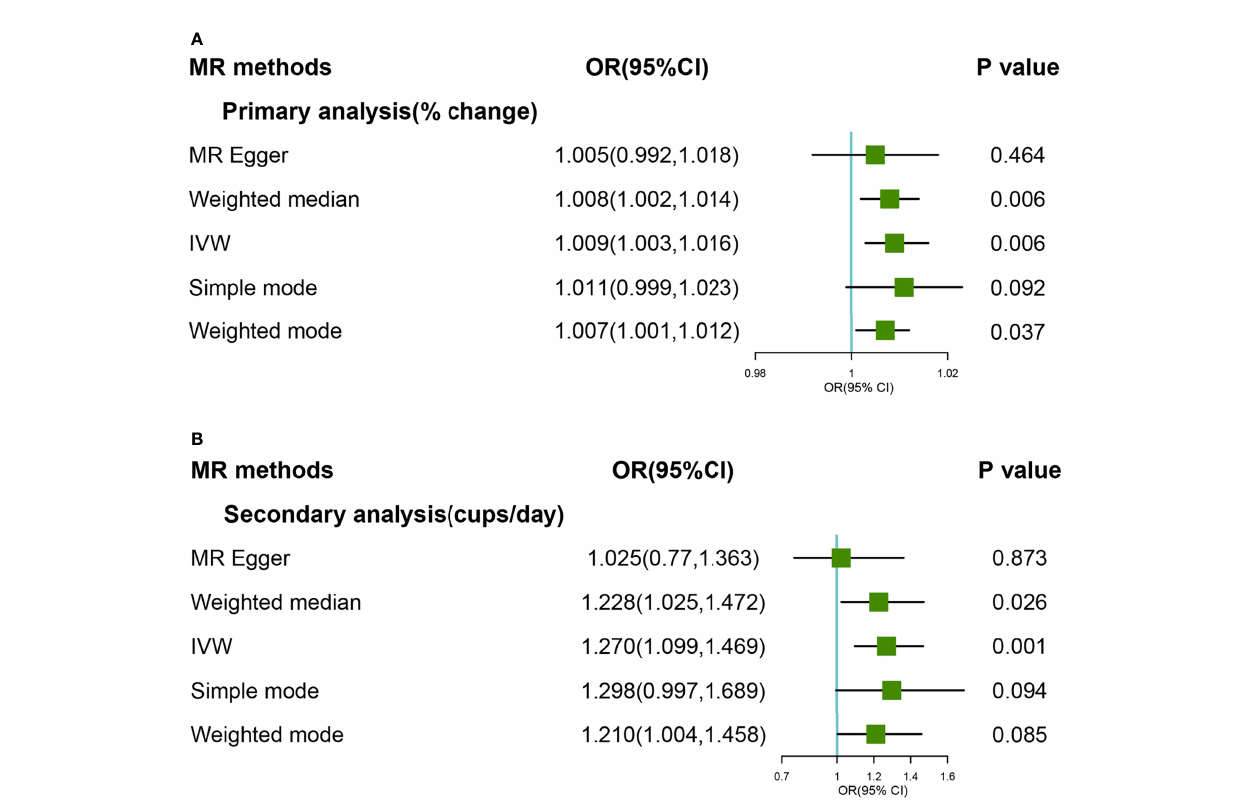
FIGURE 1 | Forest plot of MR study using (A)> primary genetic instruments with total OA. MR, Mendelian randomization; OR, odds ratio; CI, con fi dence interval; IVW, inverse variance weighted; OA, Osteoarthritis. Forest plot of MR study using (B) secondary genetic instruments with total OA. MR, Mendelian randomization; OR, odds ratio; CI, con fi dence interval; IVW, inverse variance weighted; OA,